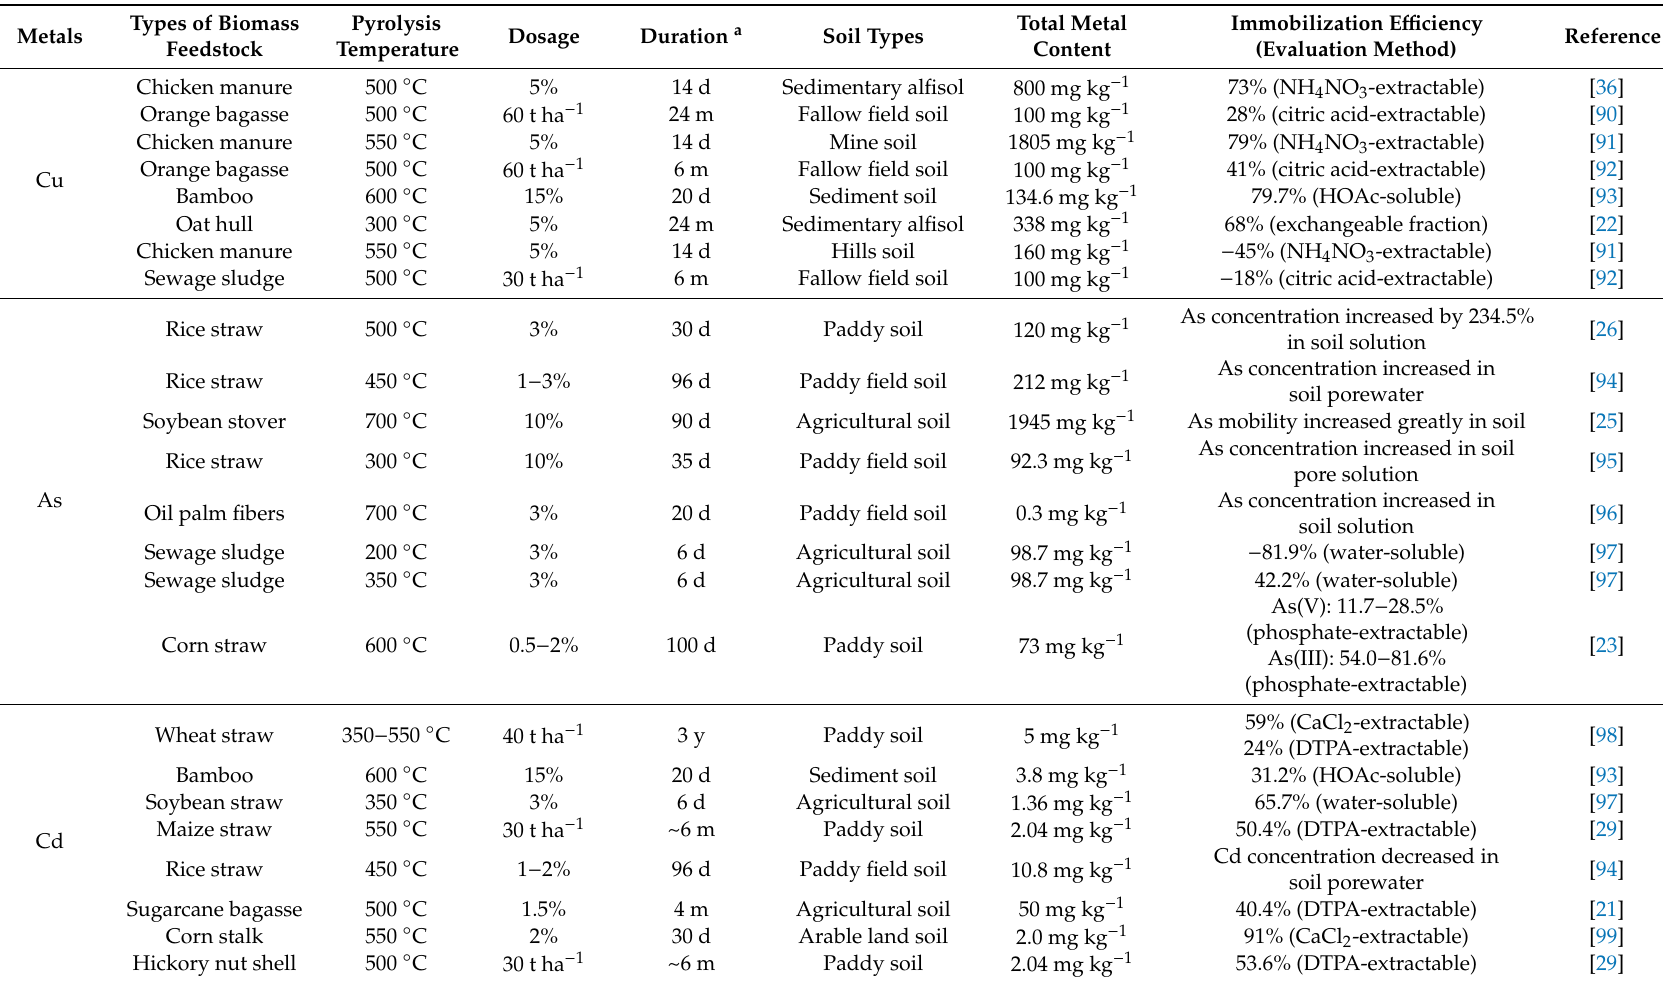
Table 2. Remediation e ffi ciency of biochar on HM (heavy metal)-contaminated